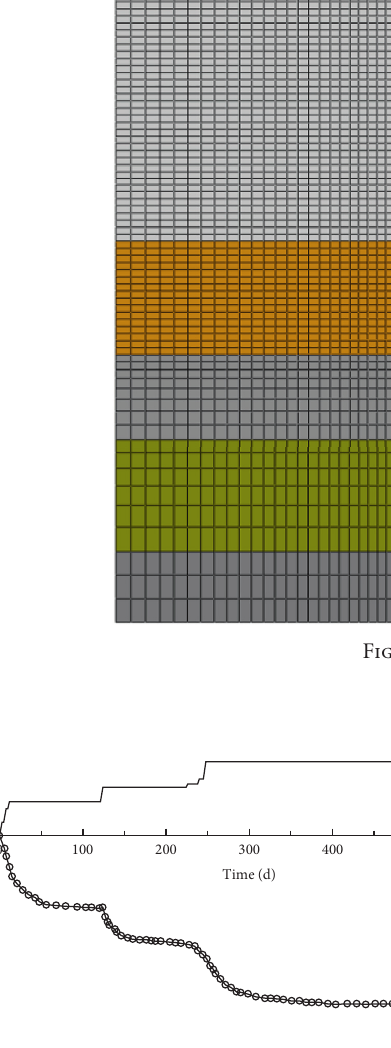
Figure 5: Settlement measured results.